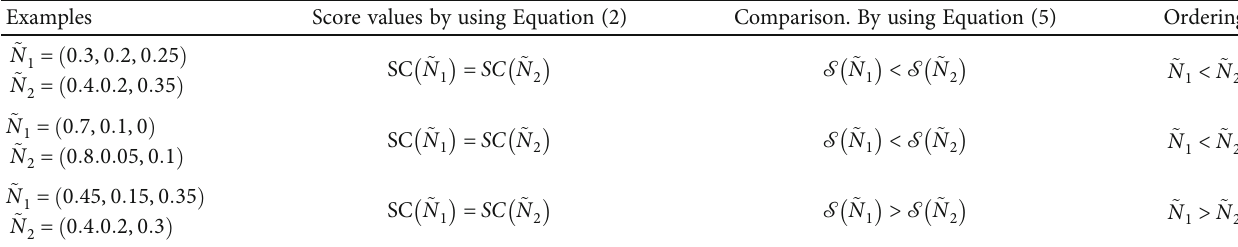
Table 1: Comparison of score